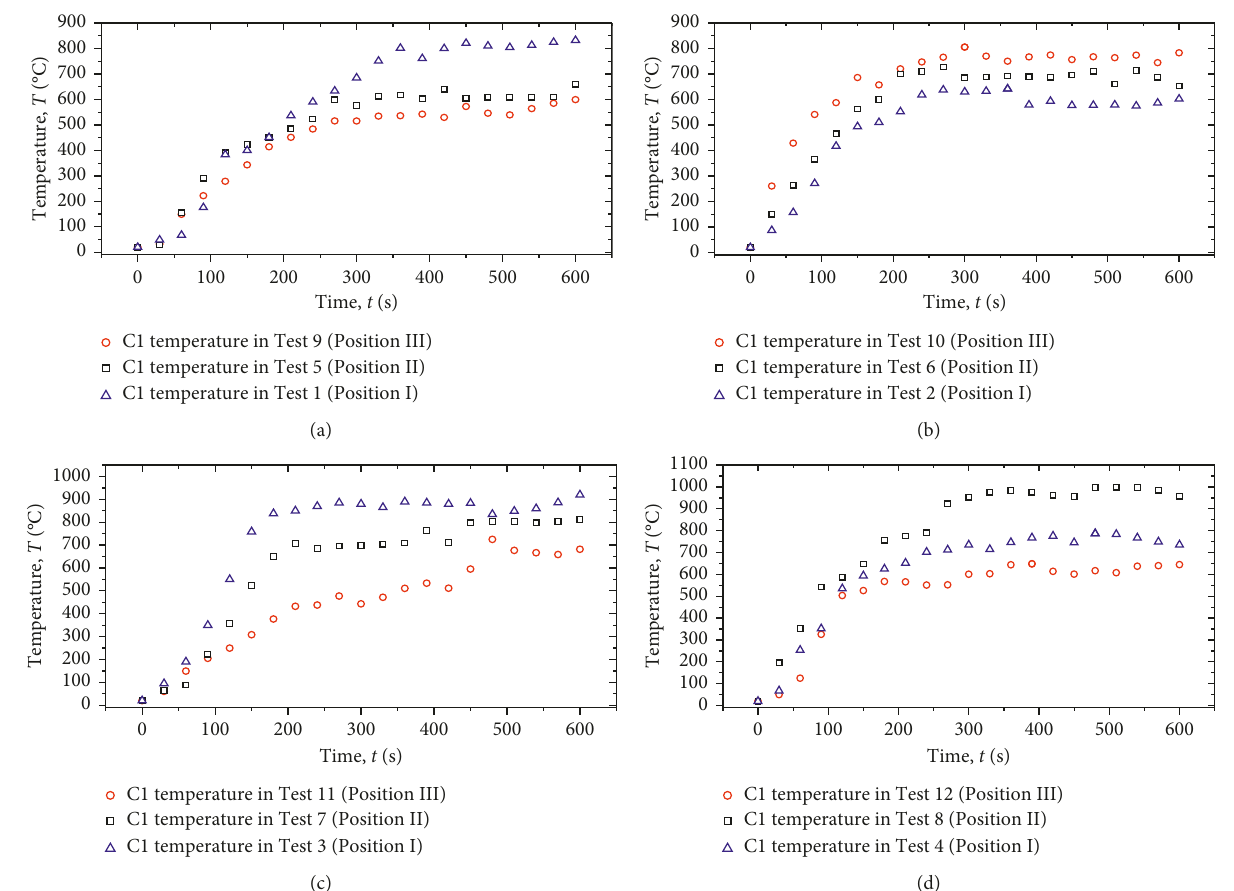
Figure 8: Temperature increase in the tunnel. (a) V 1 � 0, V 2 � 0. (b) V 1 � 0.7, V 2 � 0. (c) V 1 � 0, V 2 � 0.7. (d) V 1 � 0.7, V 2 �